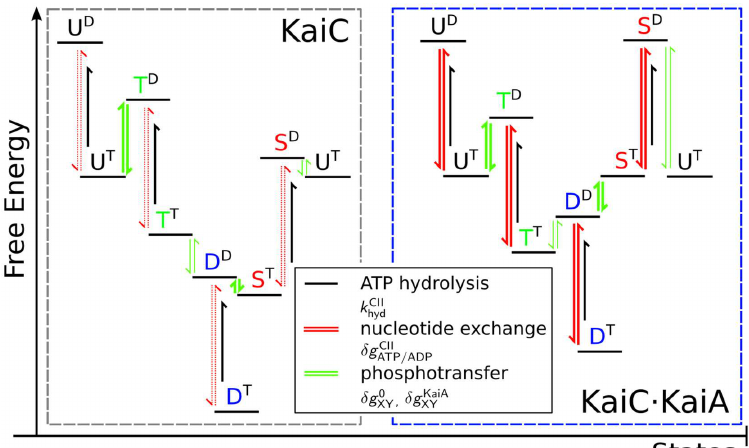
Fig 3. Proposed free energy landscape of the CII domain, without (left gray box) and with (right blue box) KaiA bound to the CII domain, for equal concentrations of ATP and ADP in the bulk. Superscripts denotethe nucleotideboundstate of CII. The landscaperesults from hand-tuningthe phosphotransfer and nucleotide exchangeparametersas well as the free-energy changesdue to KaiA bindingto give best agreement with the (de)phosphorylation assays performed in the SI of [27]. The free energy differences betweenphosphorylation states are definedby the detailed-balance relations, d g 0 d g KaiA ¼ (cid:0) log ð k KaiA = k KaiA Þ without and with KaiA bound to CII (connected by green arrows), respectively.Thick XY XY YX and thin green arrows indicatehigh and low phosphotransfer rates, respectively.Furthermore, d g CII ¼ log ð K CII Þ , gives the free-energydifference betweennucleotide bound states (connected by red ATP = ADP ATP = ADP arrows). Note that the relative nucleotide affinity is independentof the KaiA-binding state or phosphorylation state. Dotted red arrows indicate the nucleotides exchangerates are identically zero when KaiA is not bound to CII, and solid red arrows in the right panel indicatehigh nucleotide exchangerates when KaiA is bound. The black arrows denote the irreversiblehydrolysisof ATP. For hydrolysis, the magnitudeof the arrow does not give the free energy changeof the system since that involvesthe contribution from the phosphate release, which we do not take into account. Note that without hydrolysis, the total free-energy drop upon going